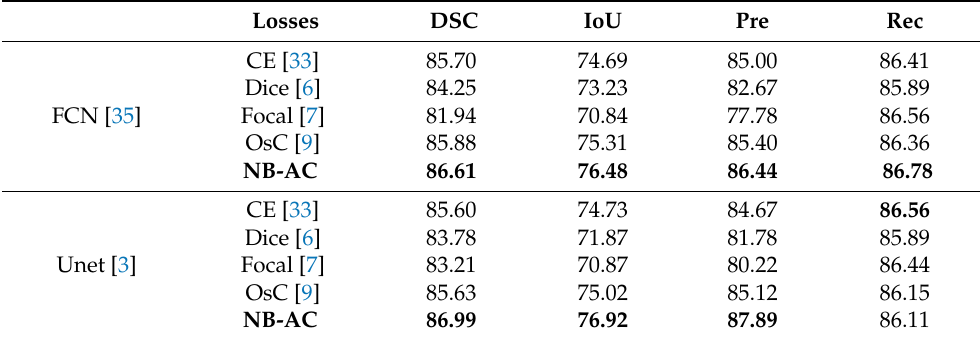
Table 2. Comparison between our proposed NB-AC loss against other losses CE [33], Dice [6], Focal [7], and OsC [9] on the MRBrainS18 dataset with the corresponding two network backbones 2D-FCN [35] and 2D-Unet [3]. The best performance is shown in bold . Losses